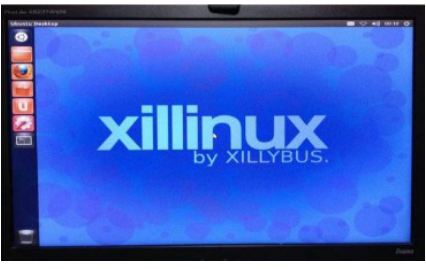
Figure 11. Xillinux display on the PC monitor